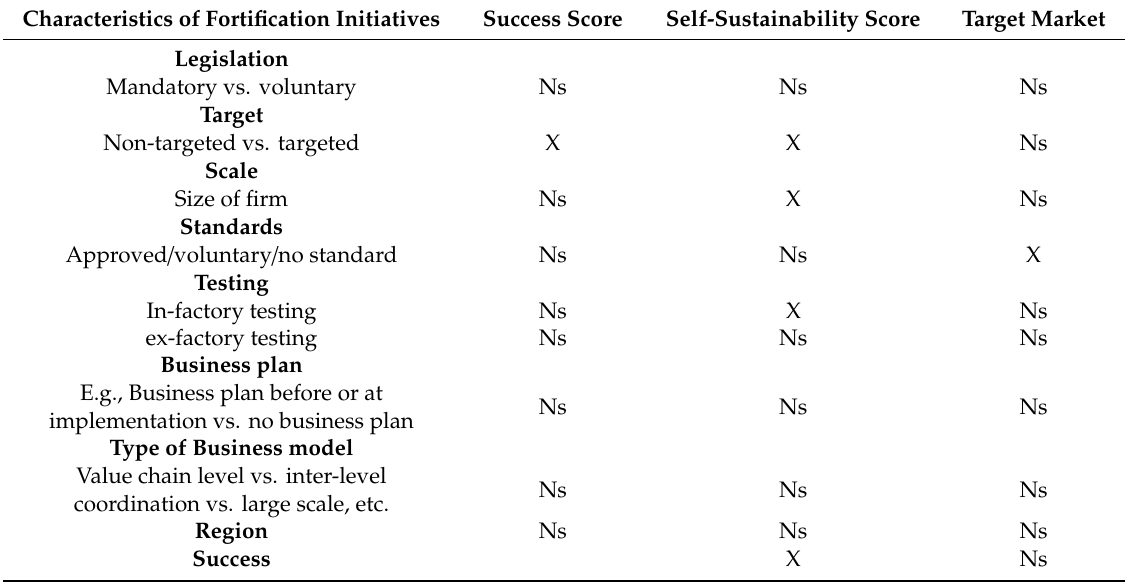
Table A1. Key characteristics of the fortification initiatives and measures of